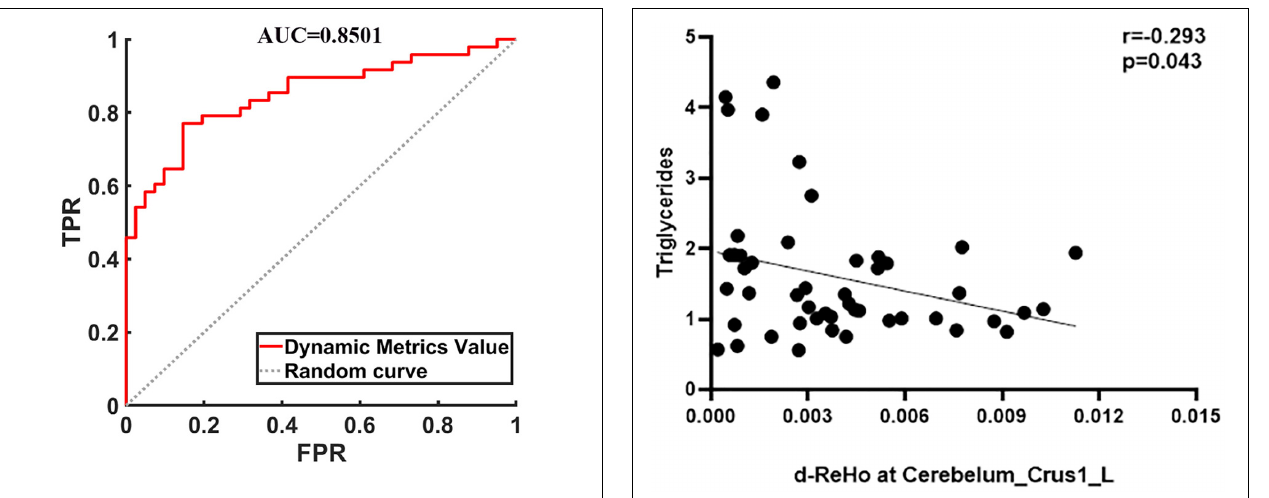
with TIA also exhibited increased d-fALFF value in the opercular part of the right inferior frontal gyrus and left calcarine. In addition, an increased d-ReHo value was observed in the cerebellum, left inferior occipital gyrus, and left inferior temporal gyrus. The values of d-ALFF, d-fALFF, and d-ReHo in regions that showed abnormal brain dynamics served as classification features, and the SVM classification achieved a total accuracy of 80.90%, sensitivity of 77.08%, specificity of 85.37%, precision of 86.05%, and AUC of 0.8501. Overall, these findings